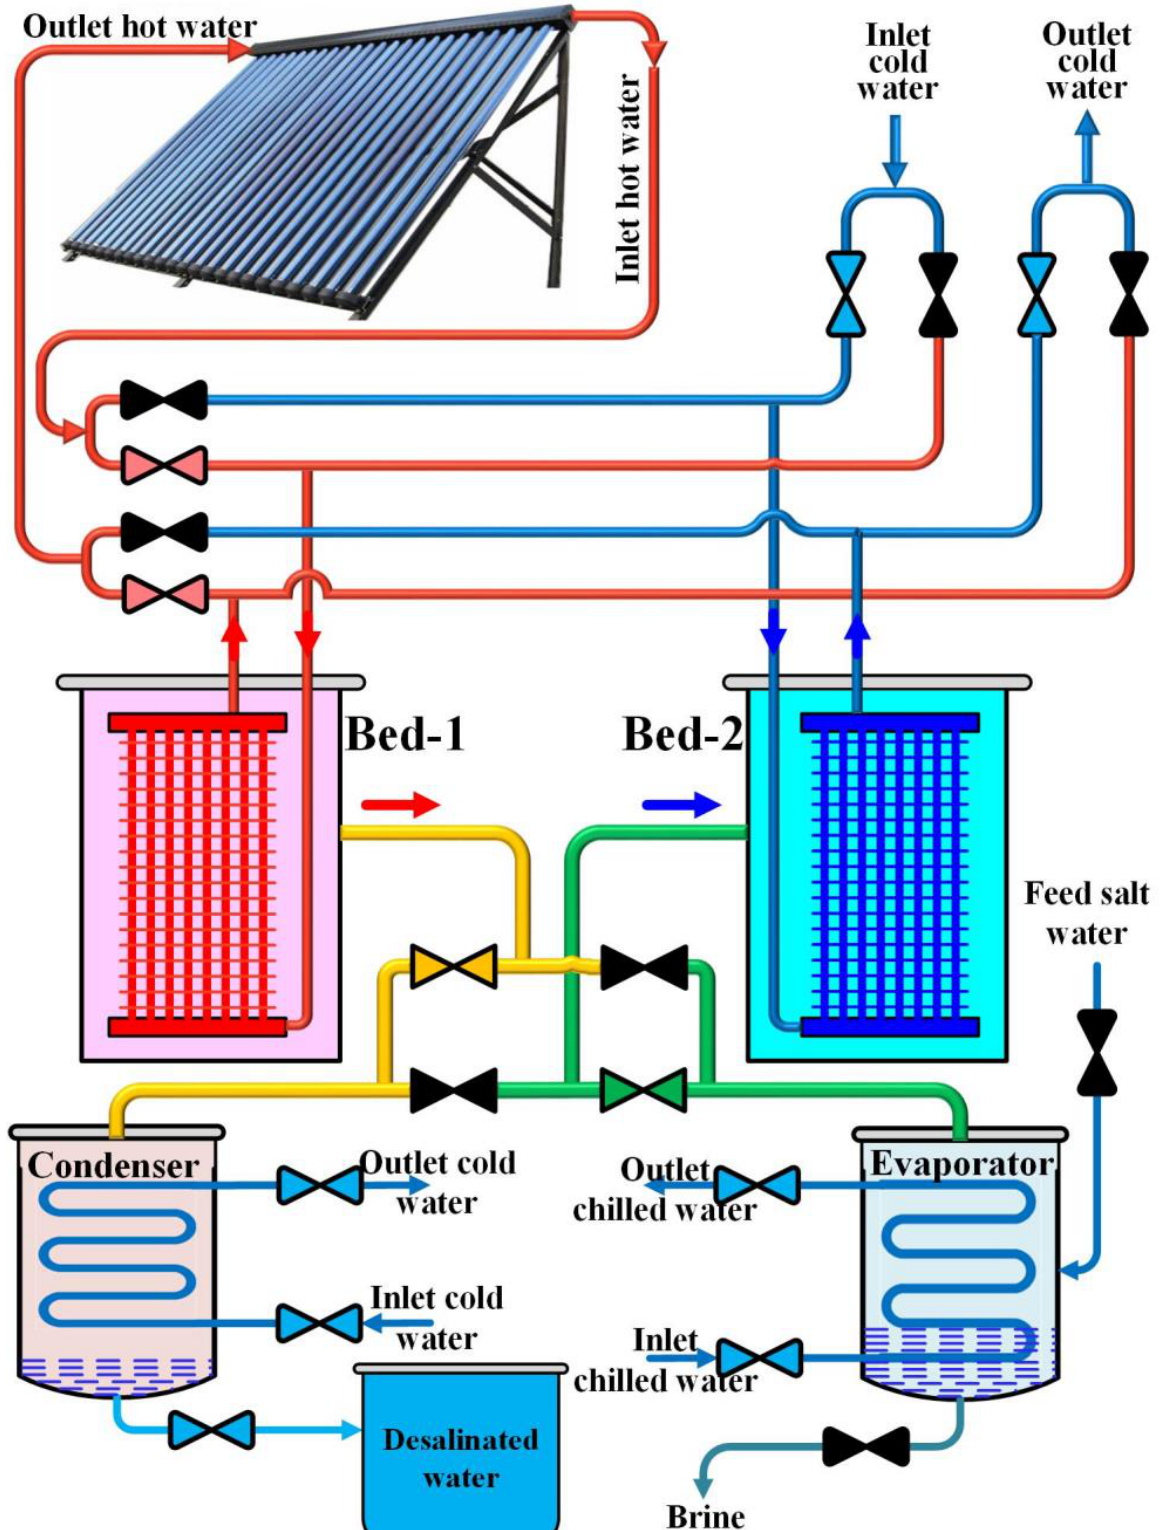
Figure 3. Schematic diagram of the SADDC system (adapted from [54]). Table 1. Summary of main research covering ADC system performance. Refs.